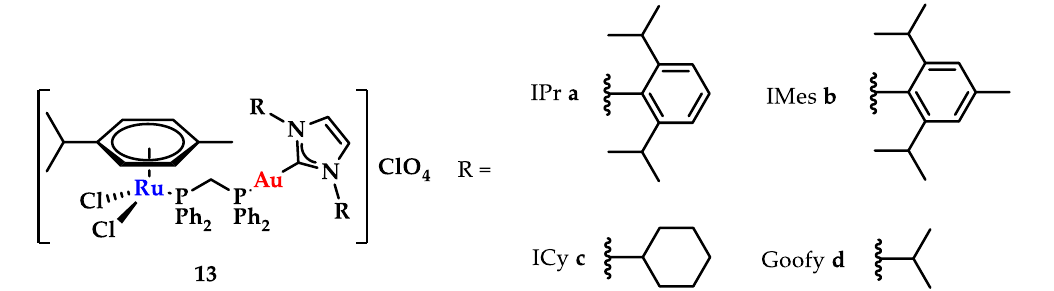
Figure 20. Heterobimetallic ruthenium-gold complexes [Ru(p-cymene)Cl 2 (μ -dppm)Au(NHC)]ClO 4 [147].